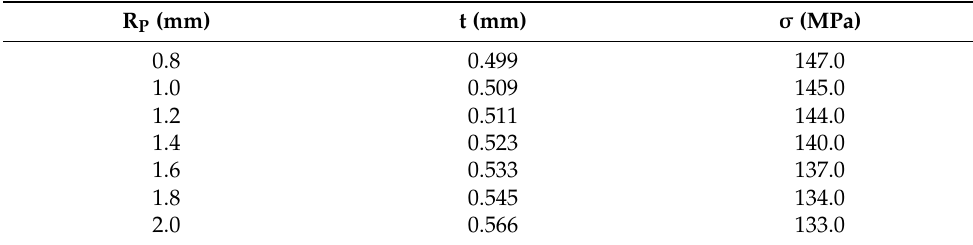
Table 5. The thickness and stress results at point F with different values of punch